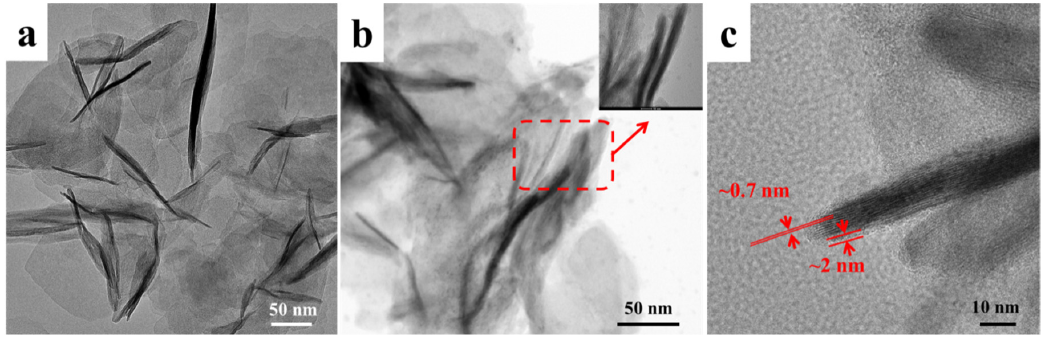
Figure 3. TEM images of ( a ) NiAl-LDHs and ( b , c ) LDHs@TA-Ti under different magnifications.